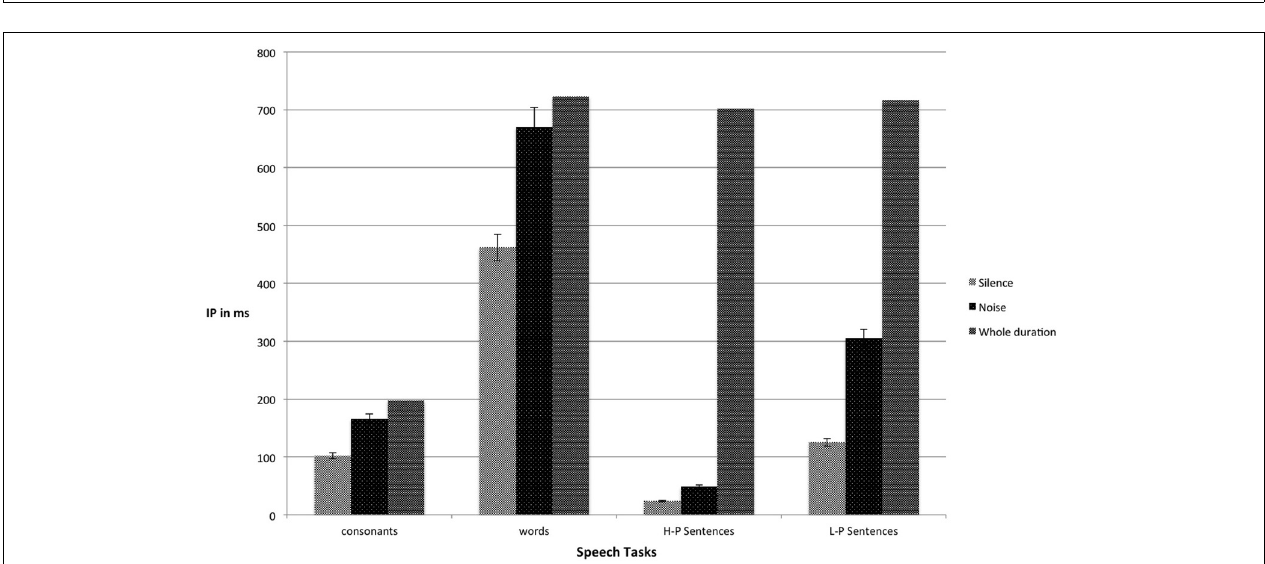
FIGURE 2 | Mean IPs (ms) for consonants, words, and final words in HP and LP sentences, in both silence and noise (with accompanying standard errors). IP, isolation point; HP, highly predictable; LP, low predictable.